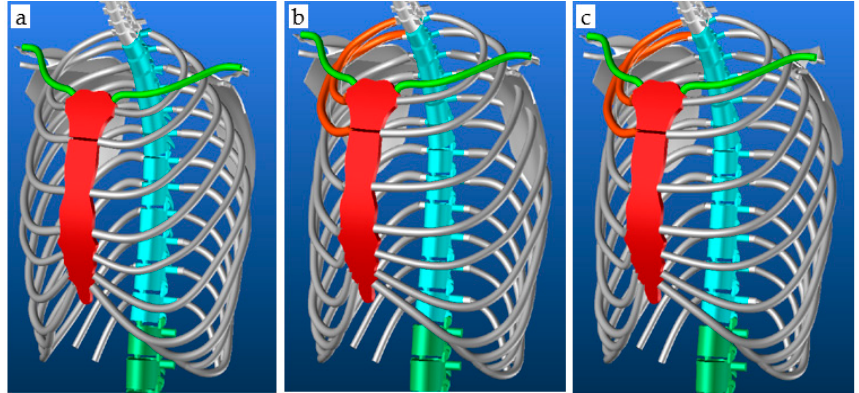
Figure 19. The ( a ) initial spine position, ( b ) spine evolution of δ = 1.5 ◦ without correction, and ( c ) spine evolution of δ = 1.5 ◦ with correction.